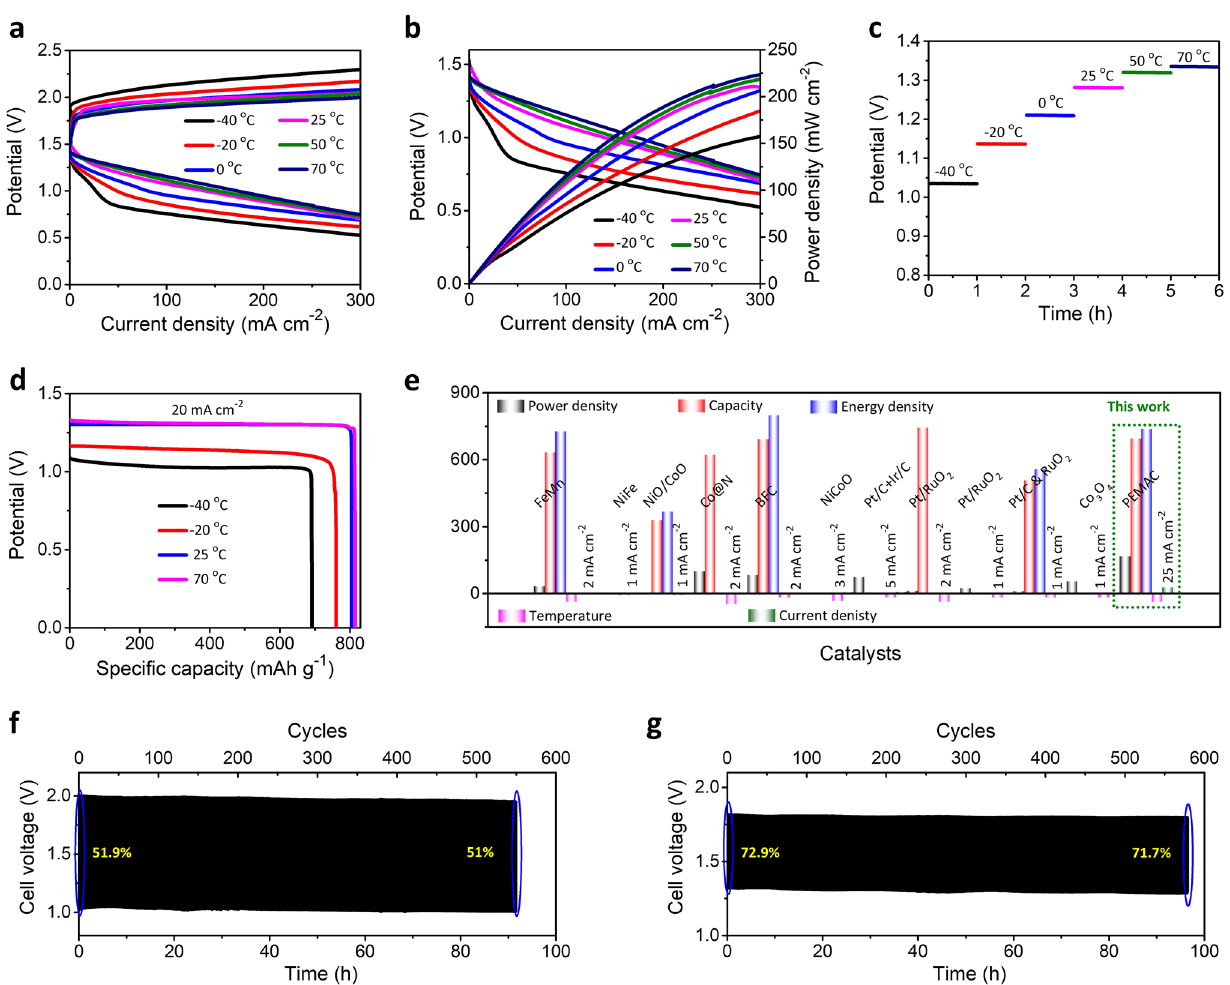
Fig. 10 All temperature range electrochemical performances of flexible ZABs. a Discharge and charge measurements for PEMAC@NDCN // CBCs // Zn for wide temperatures from − 40 to 70 °C. b Power densities and galvanostatic discharge voltage polarizations for PEMAC@NDCN // CBCs // Zn for wide range of temperatures from − 40 to 70 °C. c Discharge potentials measurement over wide temperatures at 25 mA cm −2 . d Calculated capacities and energy densities for PEMAC@NDCN // CBCs // Zn for − 40, − 20, 25, and 70 °C at 20 mA cm −2 . e Ragone plot illus‑ trates the projections over performances retentions (i.e., in terms of capacity (mAh g −1 ), power (mW cm −2 ), energy (Wh kg −1 ), temperature (°C), and current densities (mA cm −2 ) of designed PEMAC@NDCN // CBCs // Zn cells in comparison with previously reported champion ZABs for the low‑temperatures region. Note that all the reported ZABs performances are 1–5 mA cm −2 , and the measurements for this work are taken at 20–25 mA cm −2 . f and g Cycle life for PEMAC@NDCN // CBCs // Zn cells for the current rate of 25 mA cm −2 at − 40 °C and 70 °C.